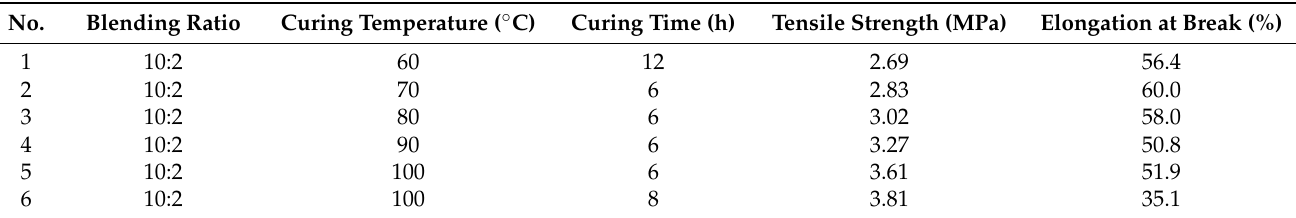
Table 5. Different tensile strengths and elongations at break under different